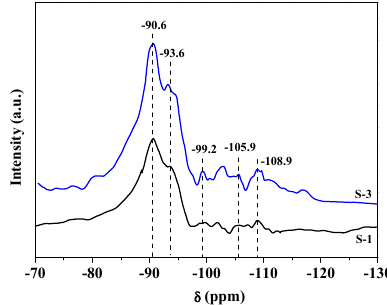
Figure 7. The 29 Si MAS NMR spectra for samples synthesized by different templates. Table 5. The distribution of silicon environments for samples synthesized by different templates.